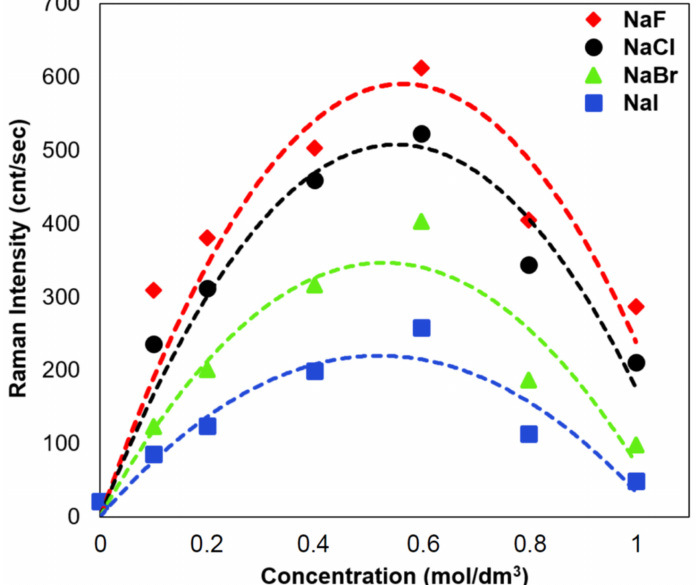
Figure 8. The dependence of the intensity of the dopamine band at 1490 cm − 1 as a function of the concentration of introduced halides: ( (cid:4) ) NaI, ( (cid:78) ) NaBr, ( • ) NaCl, and ( (cid:7) )